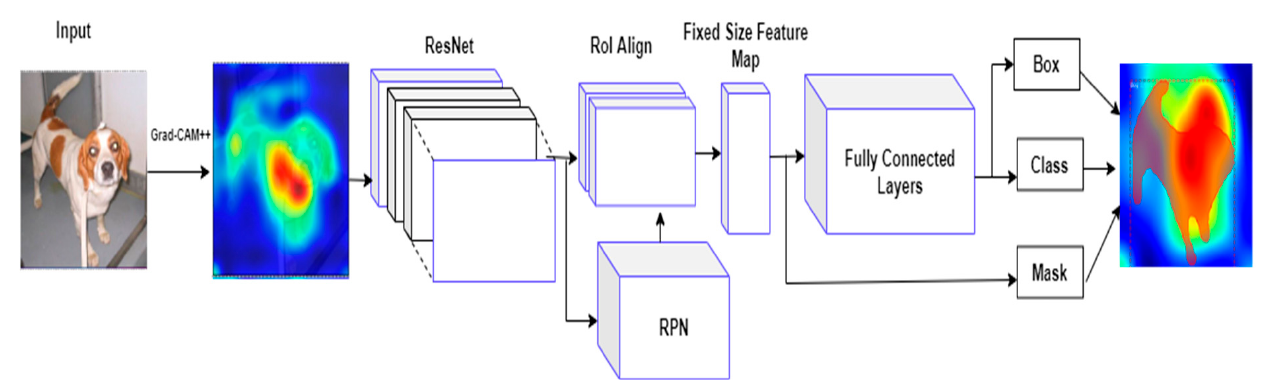
Figure 1. Architecture of the proposed method (GradCAM-MLRCNN).